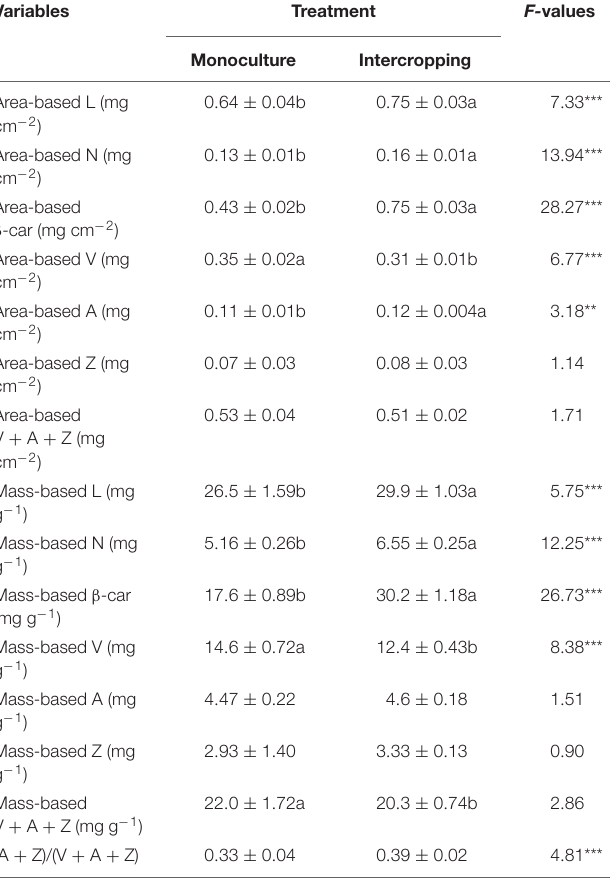
Different letters in the same row indicate statistically significant differences at the level of ≤ 0.05. *P < 0.05, **P < 0.01, and ***P < 0.001. L, lutein; N, neozanthin;